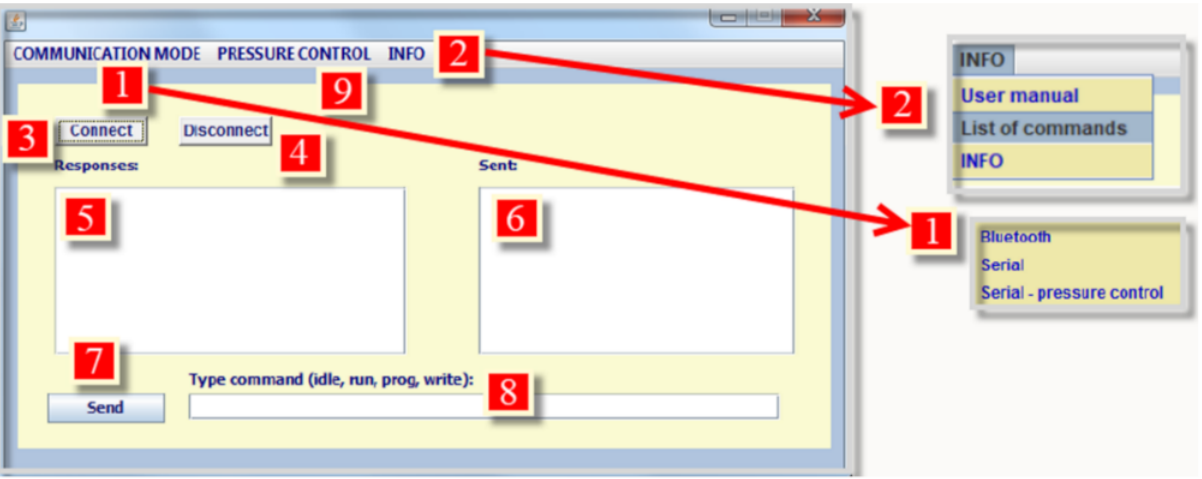
Figure 7. User application.